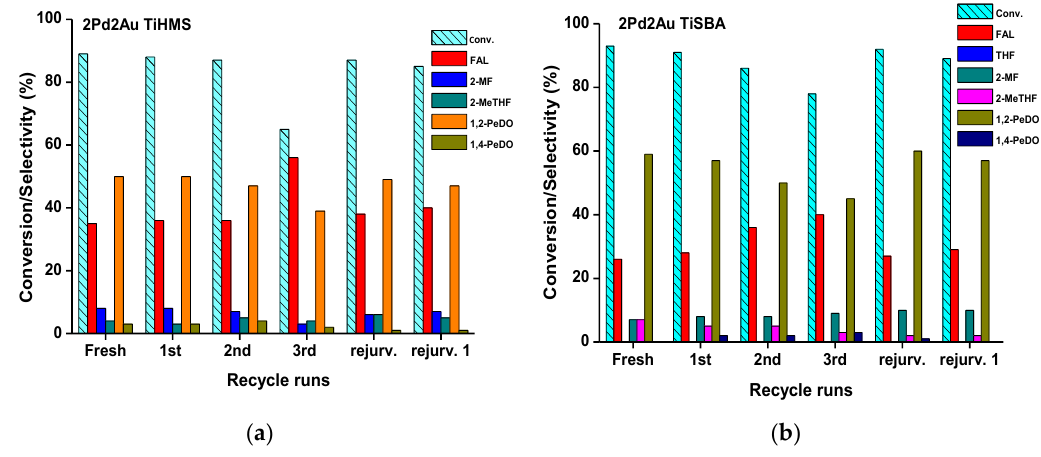
Figure 3. Catalyst recycle runs 2Pd2AuTiHMS ( a ) and 2Pd2AuTiSBA ( b ). Reaction conditions: furfural, 2.5 g; catalyst, 0.25 g; T 160 °C; H 2 500 psi; 1000 rpm; time 5 h.